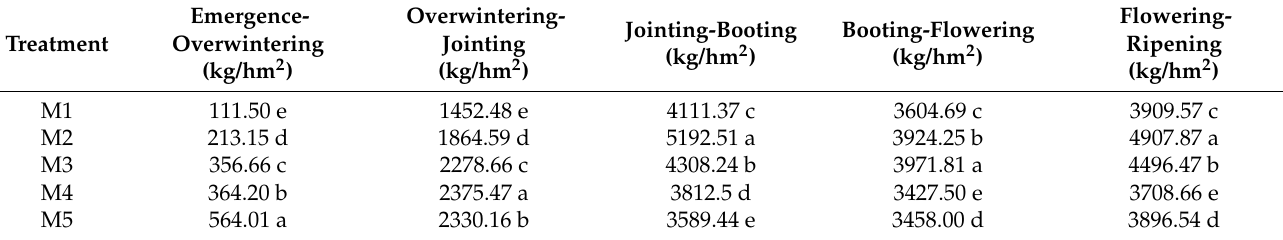
Table 6. Effects of plant density on dry matter accumulation at the reproductive